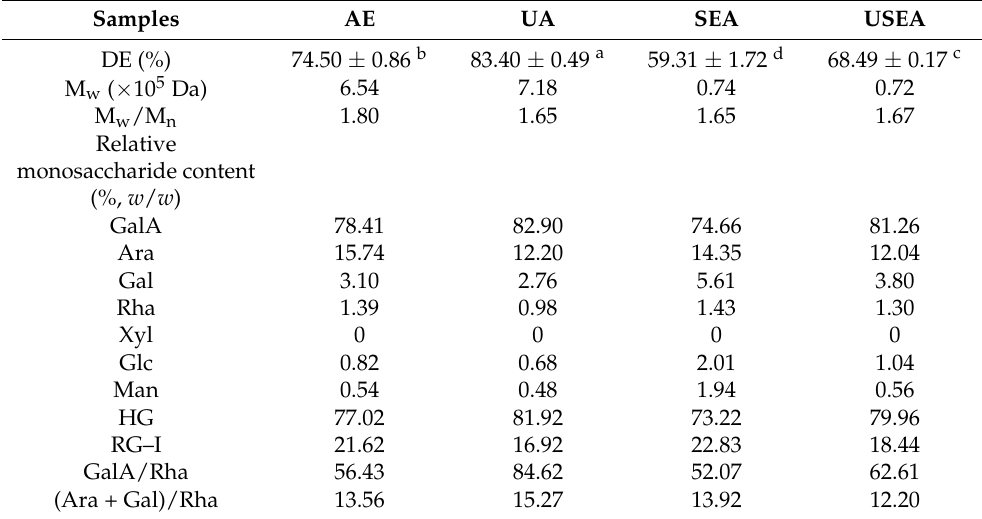
Table 2. DE value, molecular weight and monosaccharide distribution of